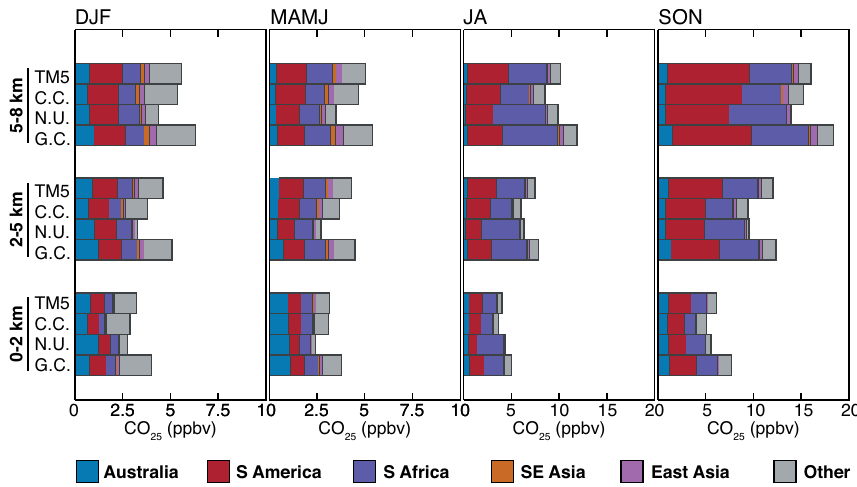
Figure 7. Contributions to CO 25 in the Cape Grim background region from sources in Australia (111–156 ◦ E, 11–44 ◦ S), South America (34–84 ◦ W, 57 ◦ S–1 ◦ N), southern Africa (9–44 ◦ E, 5–37 ◦ S), Southeast Asia (94–156 ◦ E, 11 ◦ S–7 ◦ N), East Asia (91–144 ◦ E, 7–44 ◦ N), and elsewhere, as simulated by GEOS-Chem (G.C.), NIWA-UKCA (N.U.), CAM-chem (C.C.), and TM5 for different altitude bands and seasons in 2004–2005. Note the difference in scale between DJF–MAMJ and JA–SON.